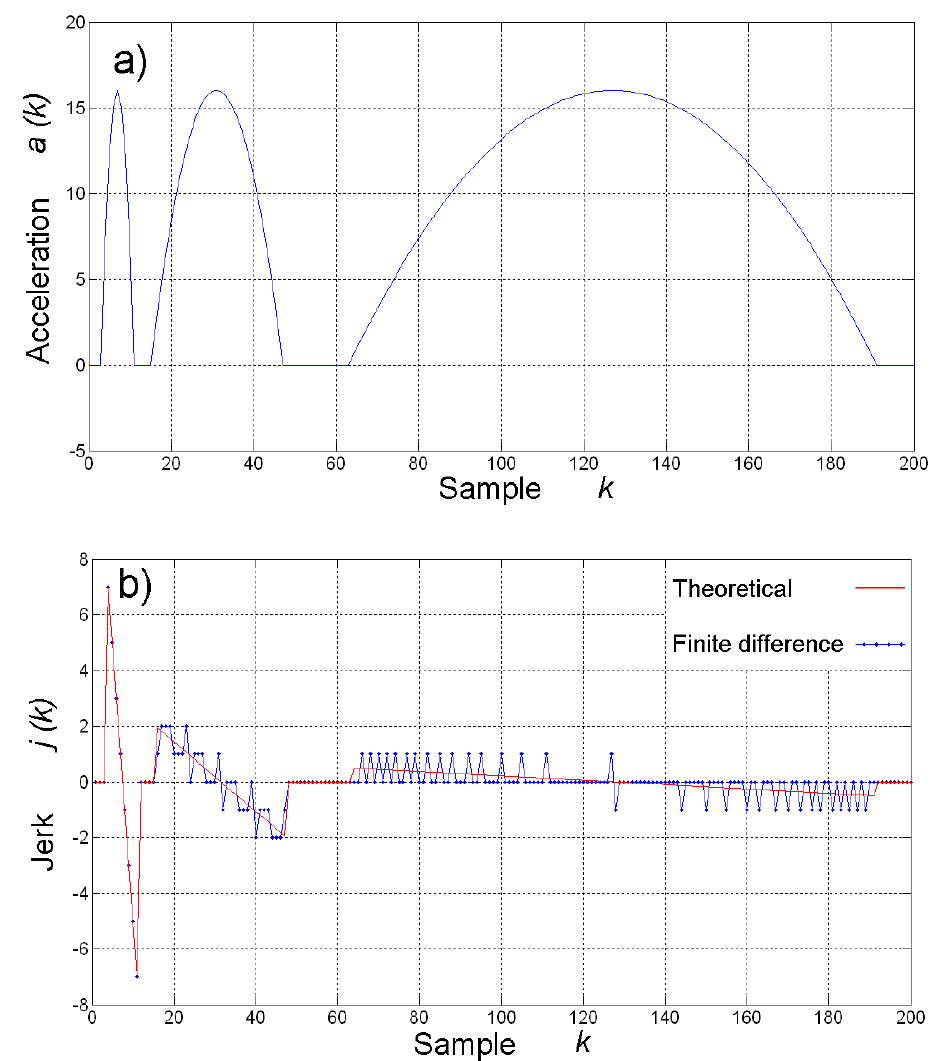
Figure 2. (a) Piecewise quadratic acceleration profile. (b) Theoretical and finite-difference